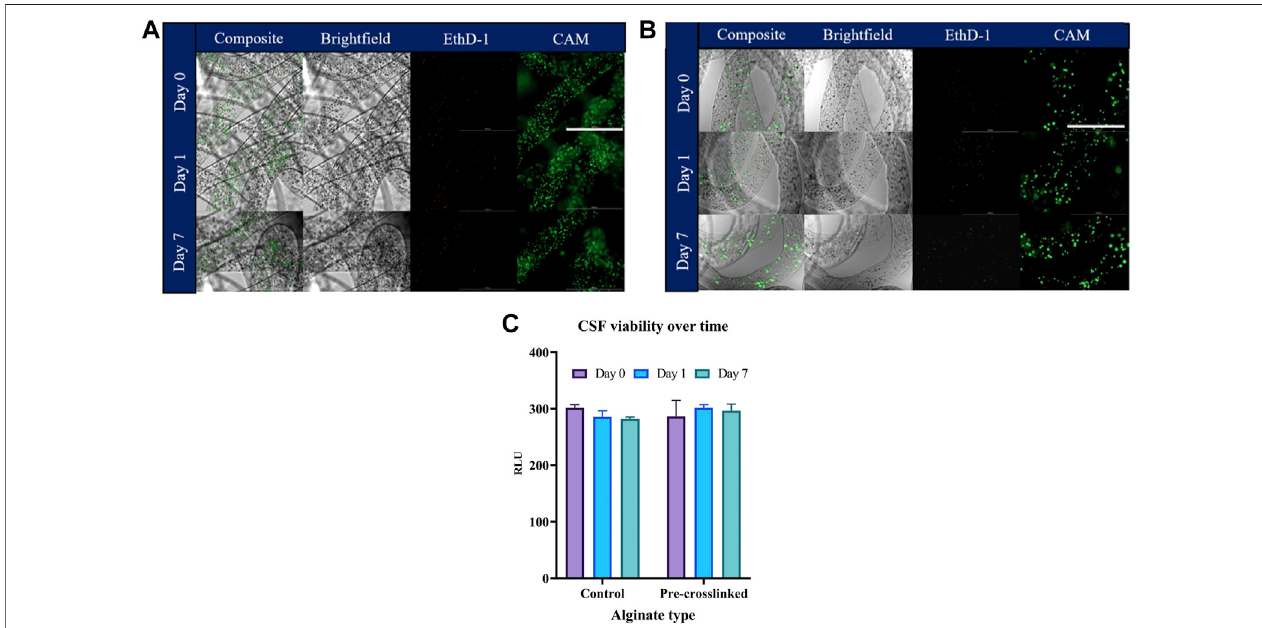
FIGURE 6 | Evaluation of CSF viability in pre-crosslinked alginate fi bers. Cell-laden fi bers were formed by wet spinning prior to being stained with CAM (live stain) and Ethd-1 (dead stain) and imaged. Control alginate fi bers are presented in (A) , pre-crosslinked alginate fi bers are presented in (B) , metabolic assessment of CSF viability by CellTiterGlo is displayed in (C) . Values are expressed as mean ± SD from three separate experiments. Scalebar corresponds to 1000 µm.